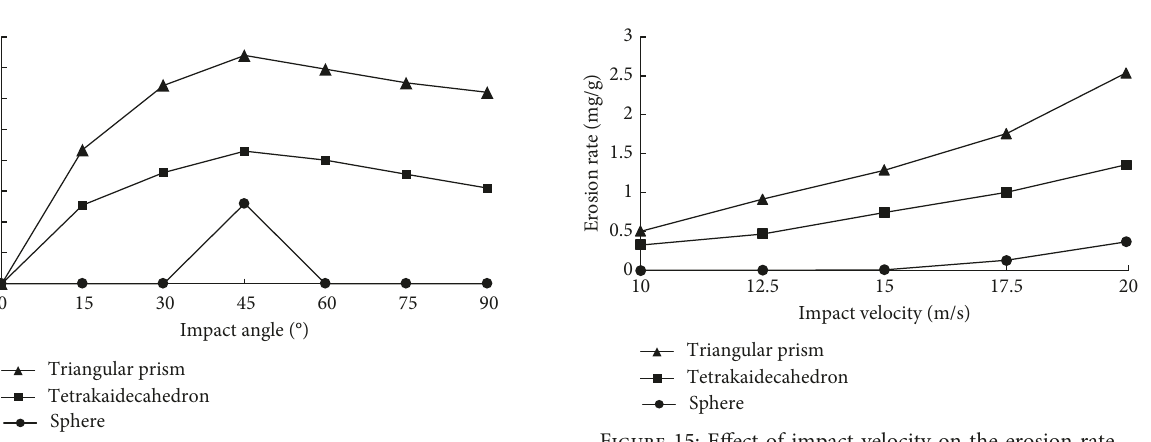
Figure 14: Effect of the impact angle on the erosion rate.